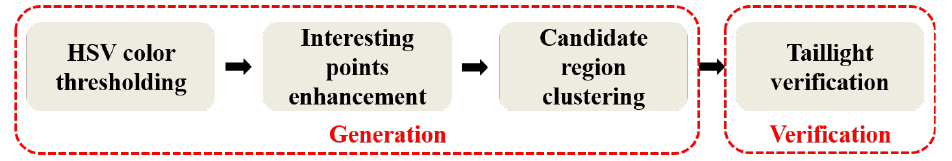
Figure 4. Proposed taillight detection